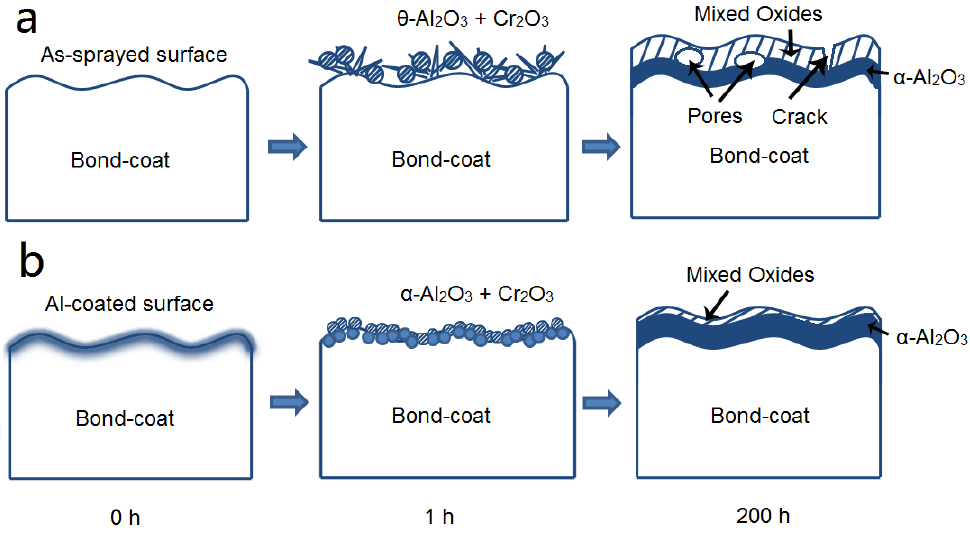
Figure 10. Schematic diagram illustrating the isothermal oxidation behavior of bondcoat